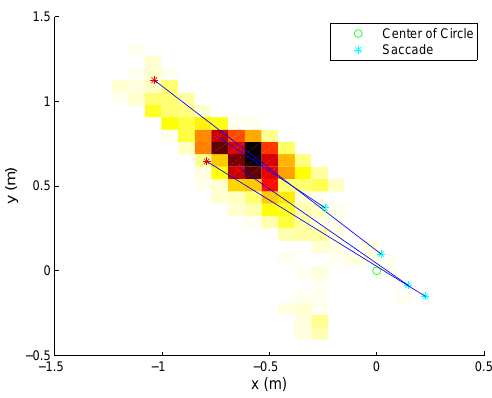
Figure 14. Gaze decomposition for the hover task within a small boundary area. The gaze is shown in the task space with smooth pursuit points shown as a density plot and saccades as gaze steps.